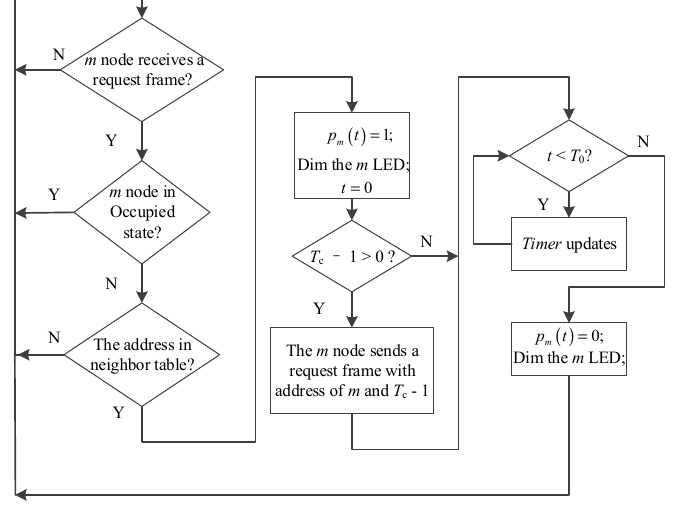
Figure 5. Flowchart of the neighbor-aided illumination control of node m .